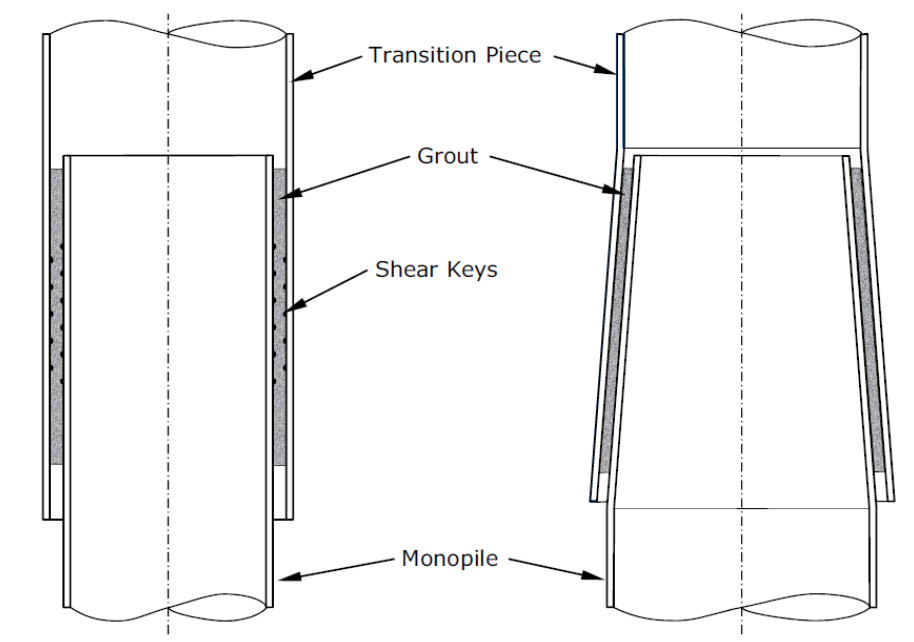
Figure 2. Revised design for grouted connection with shear keys ( left ) and cone design ( right ) (adapted from [9] with permission from DNV GL-Energy, 2016.